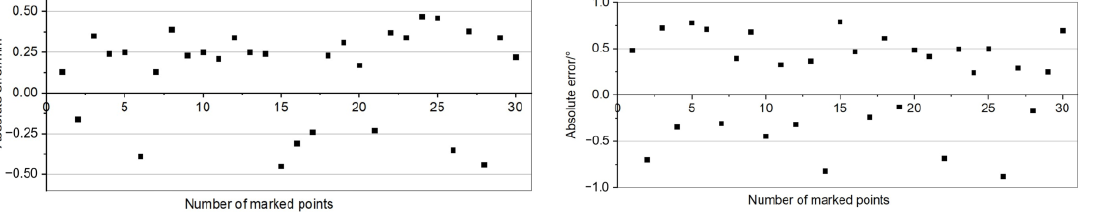
Figure 23. Validation of monitoring results.